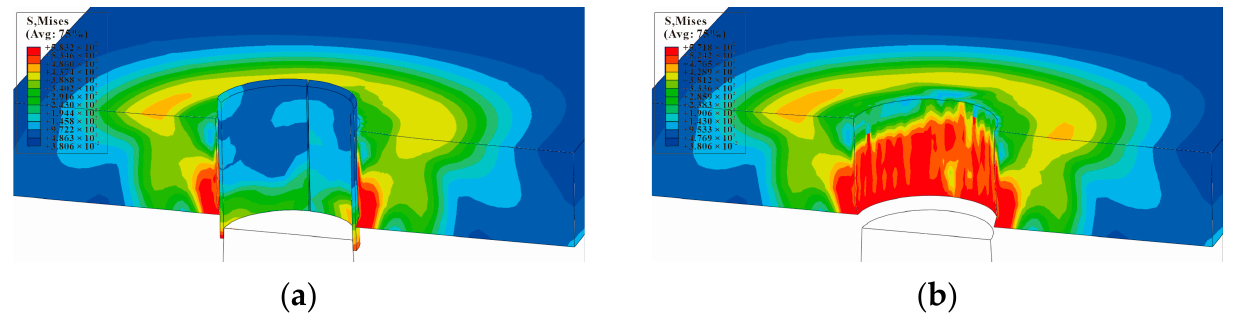
Figure 11. Equivalent von Mises stress at the cross-section of single-hole SSCE: ( a ) equivalent von